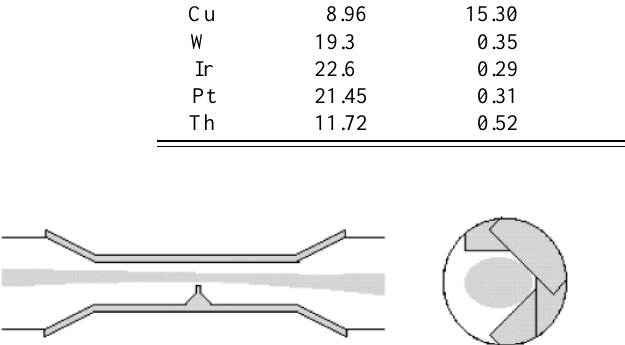
FIG. 5. (Color) Schematic view of the primary collimator. The longitudinal and transverse profiles of the vacuum pipe are shown. The structure surrounding the vacuum pipe is similar to that of Fig. 6.